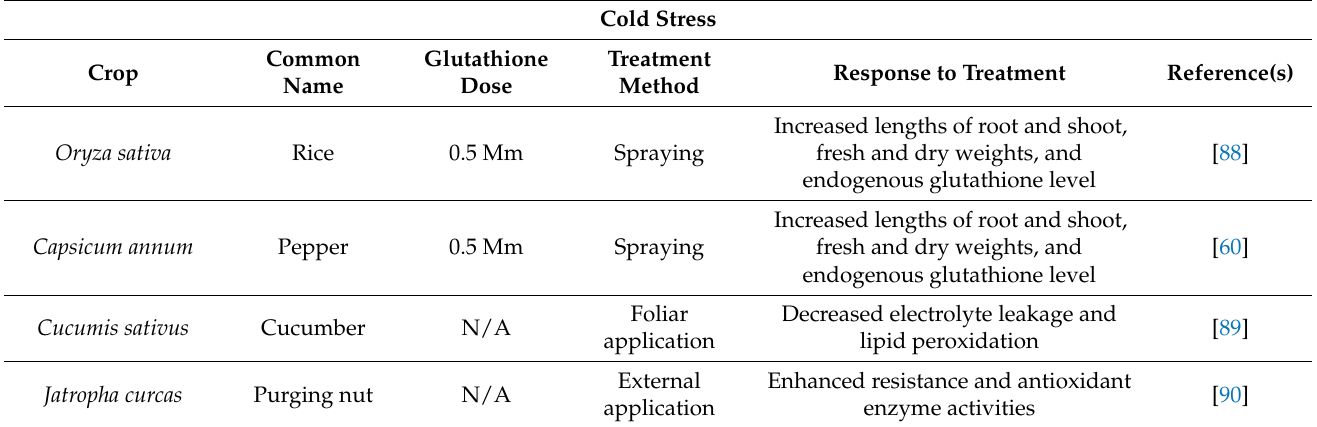
Table 9. Physiological responses of various crops to glutathione treatment against cold